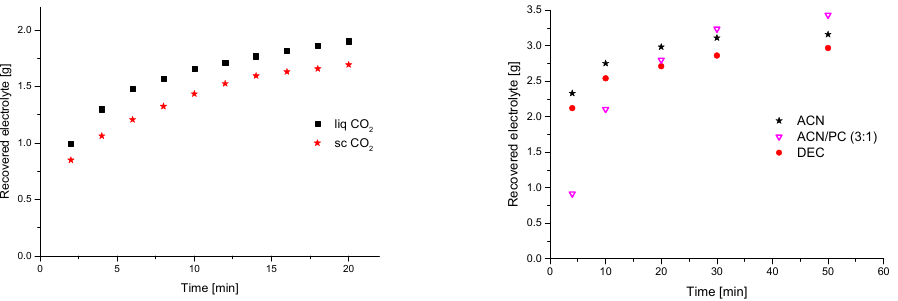
Figure 8. Response surfaces and contour plots for: ( a ) extraction time vs. pressure; and ( b ) extraction time vs. temperature. It was reproduced from reference [162] with permission from the Royal Society of Chemistry, 2014.